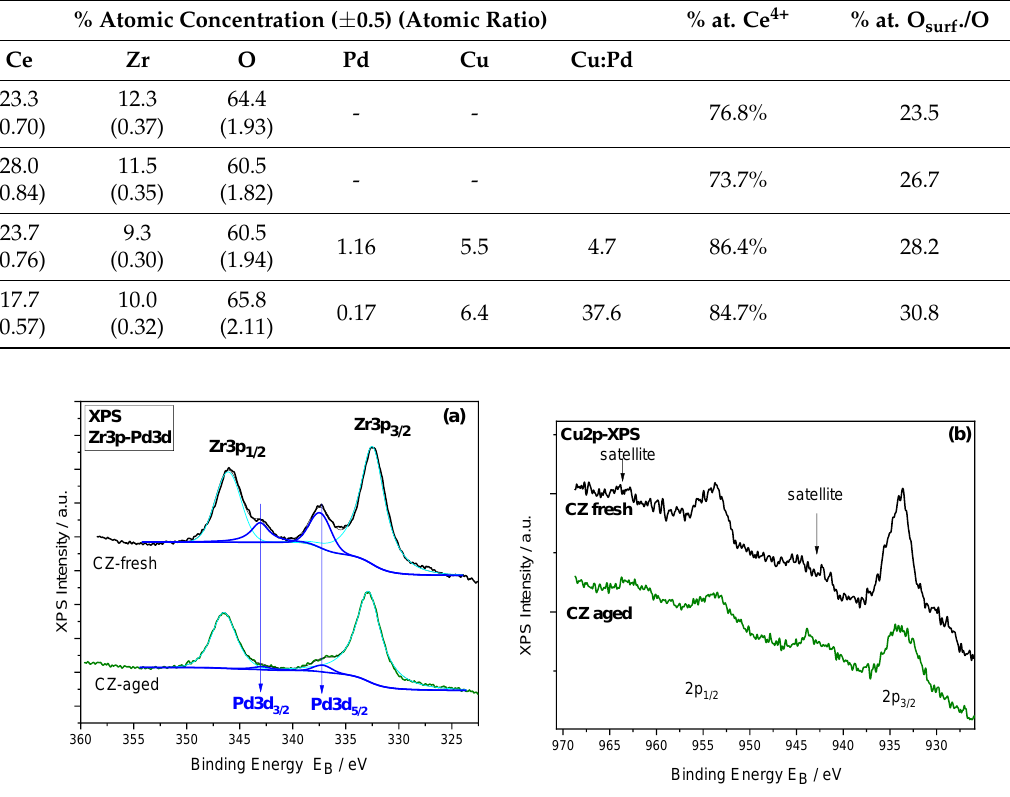
Figure 7. ( a ) Pd-Zr3p XP spectra window and ( b ) Cu2p XP spectra of PROM100-fresh and -aged.